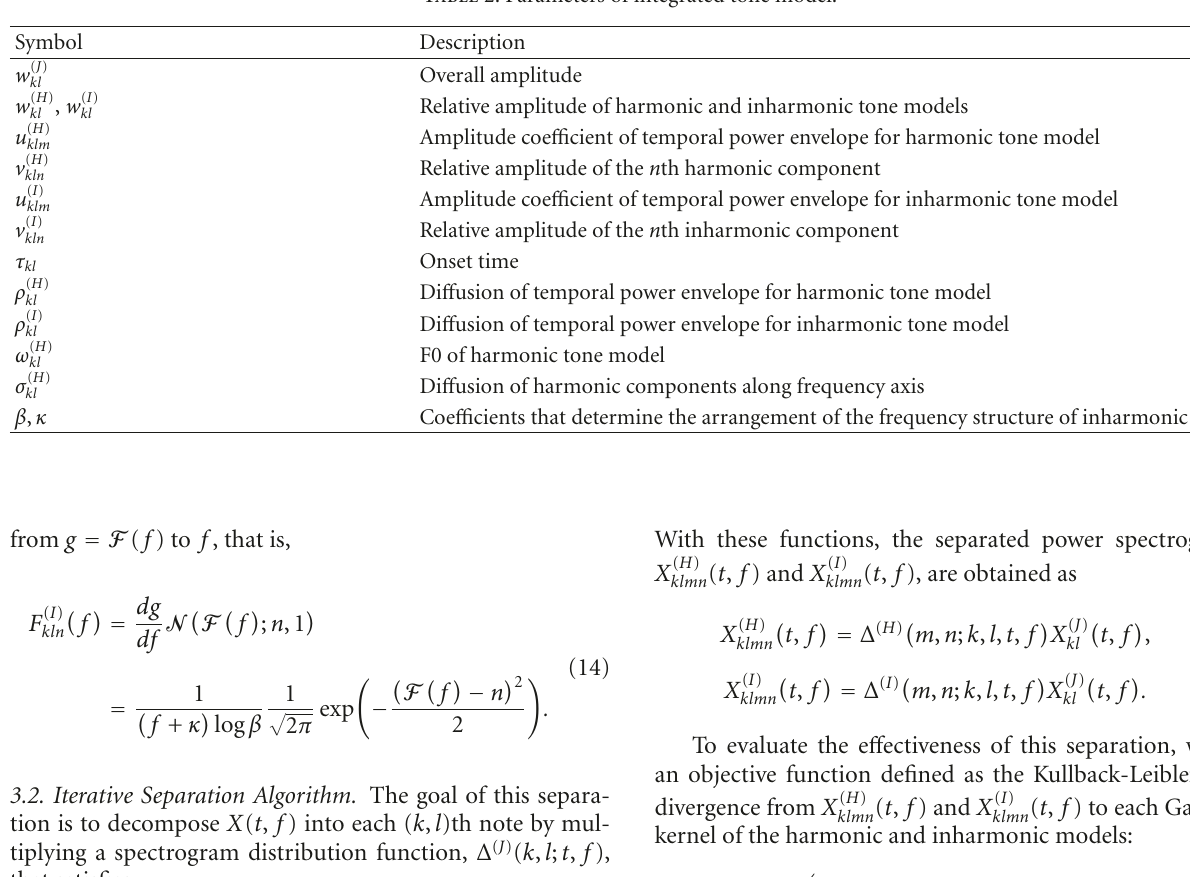
Table 2: Parameters of integrated tone